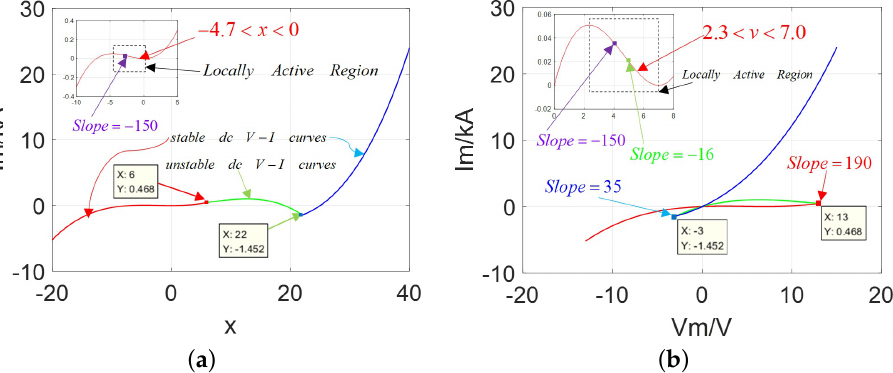
Figure 5. Graphs of current against state variable and DC V − I curve: ( a ) Ivs . X with only one negative slope domain in the over the range − 4.7 < x < 0; ( b ) Ivs . V with the negative slope domain over the variable range 2.3 V < v < 7.0 V.